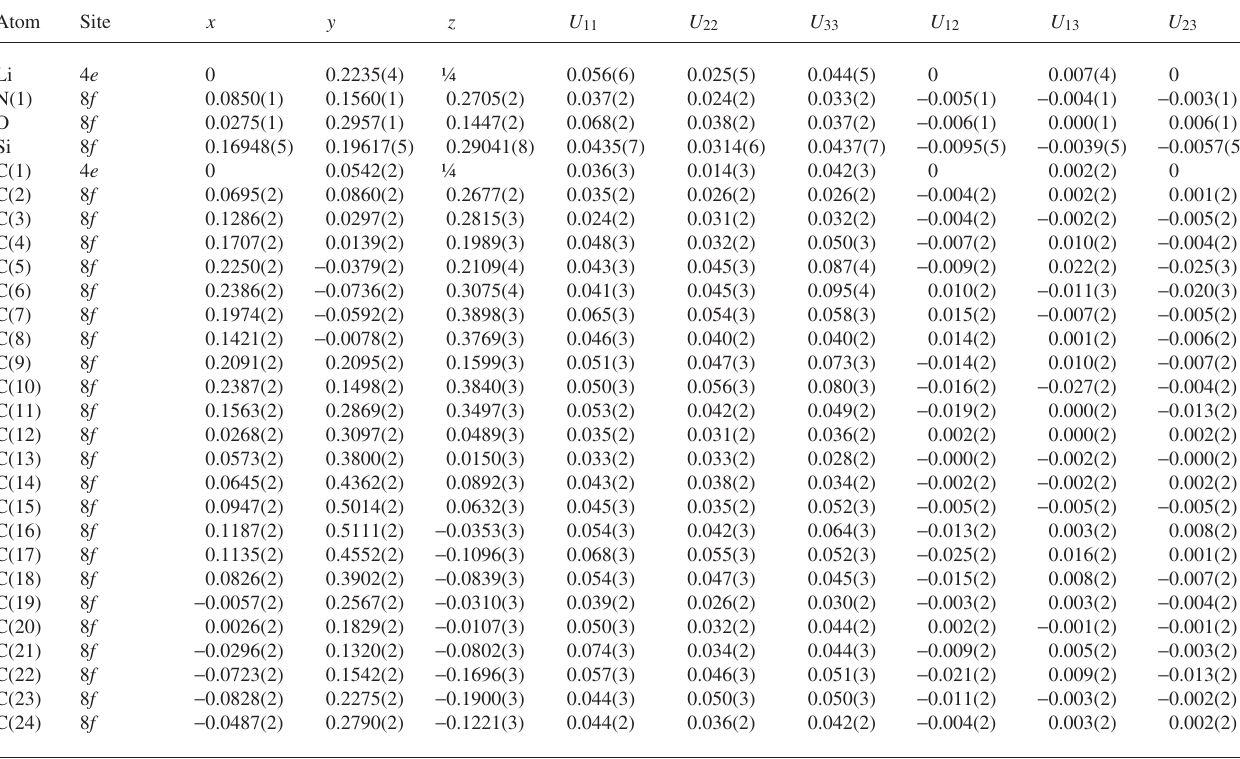
Table 3. Atomic coordinates and displacement parameters (in Å 2 )